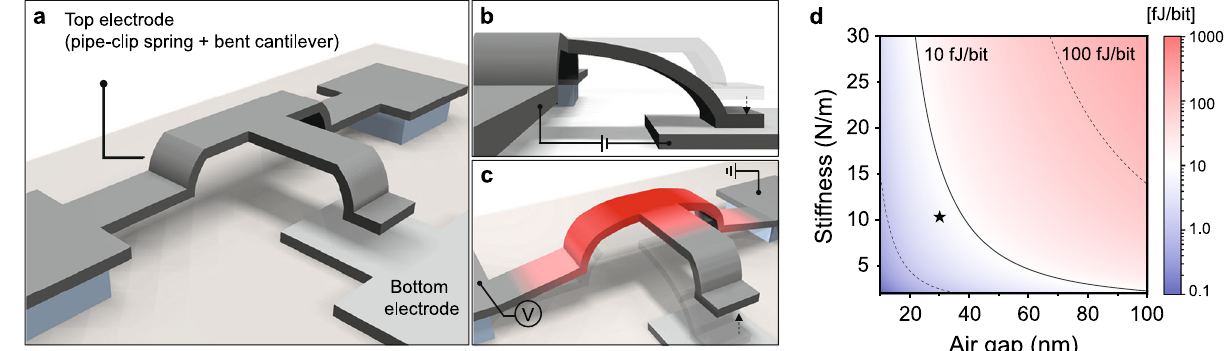
Fig. 1 | Structure,operation mechanisms, and calculatedprogramming energy ofthenanoelectromechanicalnon-volatilememory(NEM-NVM).a Schematicof the NEM-NVM with an out-of-plane electrode con fi guration. b Schematic illustra- tion of the program operation. The program operation is driven by electrostatic forceduetothevoltagedifferencebetweenthetopandbottomelectrodes,andthe adheredbentcantileverismaintainedbytheintentionallydesignedadhesionforce. c Schematic illustration of the erase operation. The erase operation is driven by